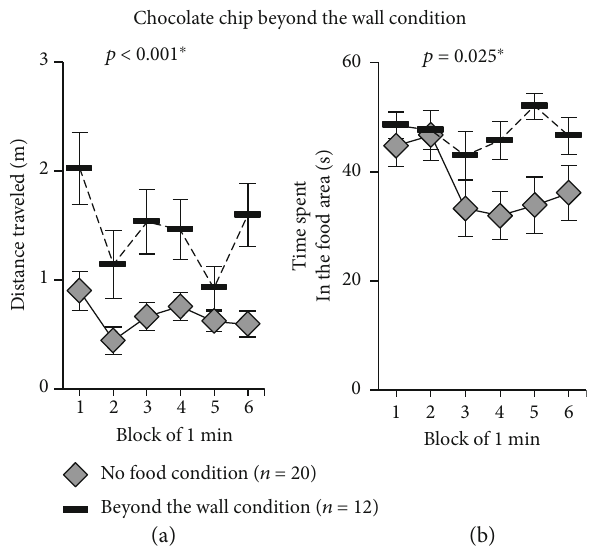
Figure 4: Feeding behavioral test of chocolate chip beyond the wall condition. Comparison of the distance traveled in each 1- minute period (a) (no food condition, n = 20 ; beyond the wall condition, n = 12 ). Comparison of the time spent in the food area in each 1-minute period (b). Data are presented as means ± SEM (a, b). Statistical signi fi cance is represented by asterisks: ∗ p < 0 : 05 . The p values were calculated by a two-way repeated measures ANOVA (a,